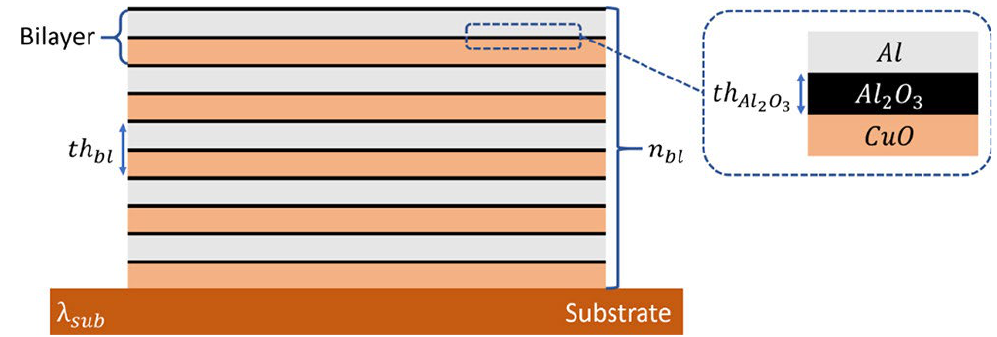
Figure 15. Schematic of the geometrical features of an Al/CuO nanolaminate deposited on a sub- strate [101]. Copyright 2022 American Chemical Society.